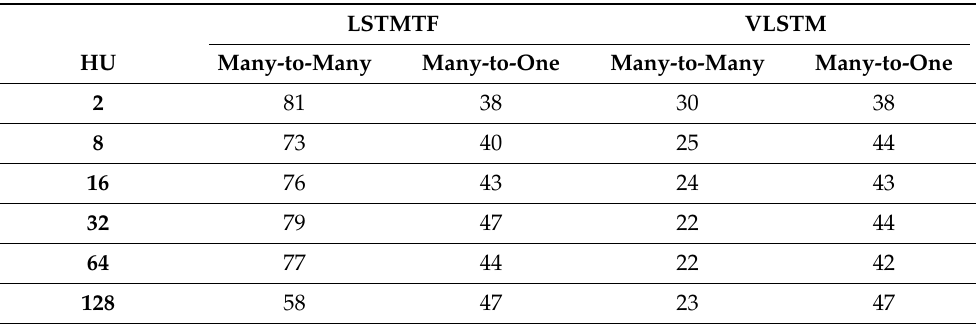
Table 6. The training convergence time (epochs) for LSTMTF and VLSTM, computed with respect to the number of hidden units, for (cid:101) = 1% and P = 5.